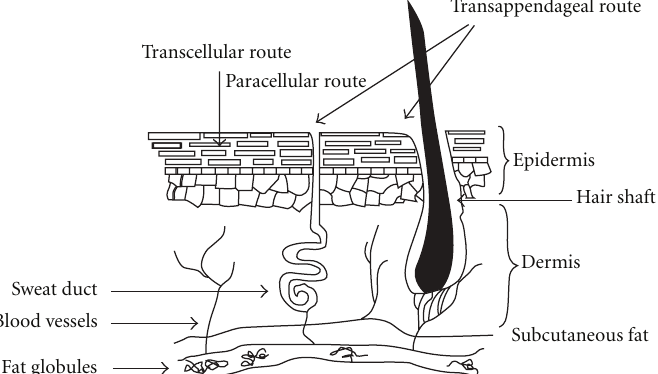
Figure 5: Transdermal routes of absorption of local anaesthetics.